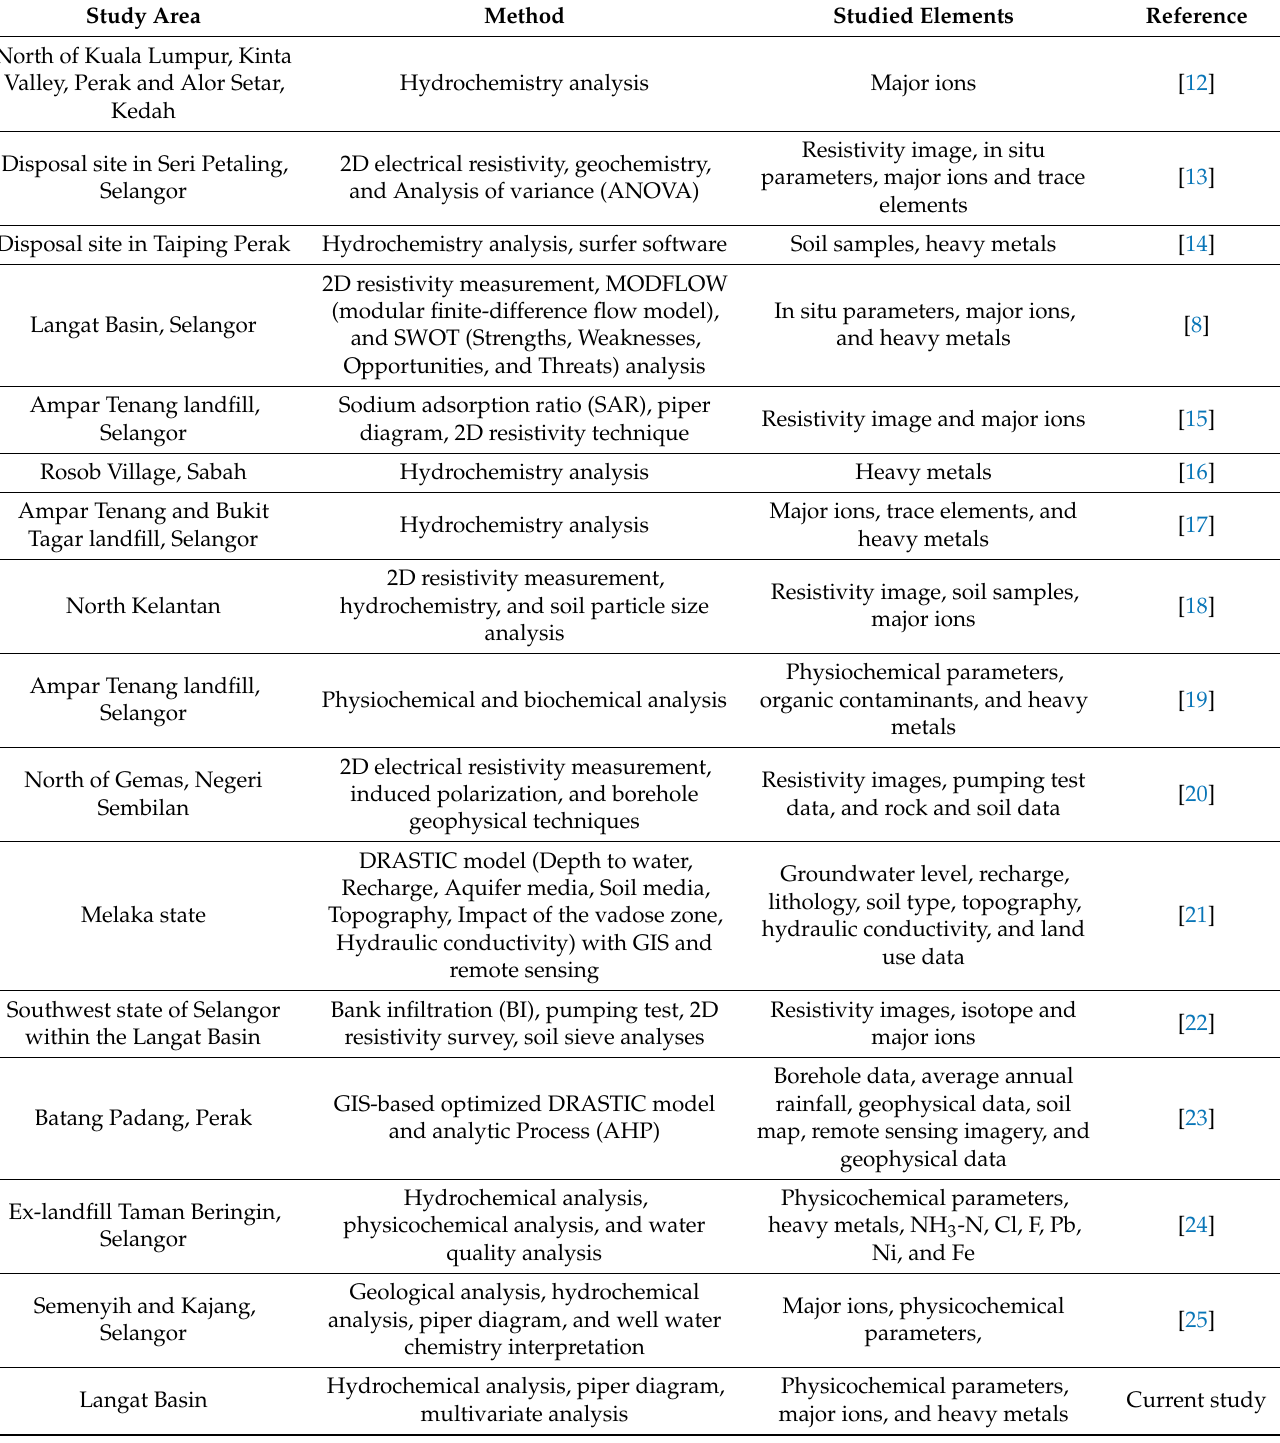
Table 1. Summary of inland groundwater contamination studies in